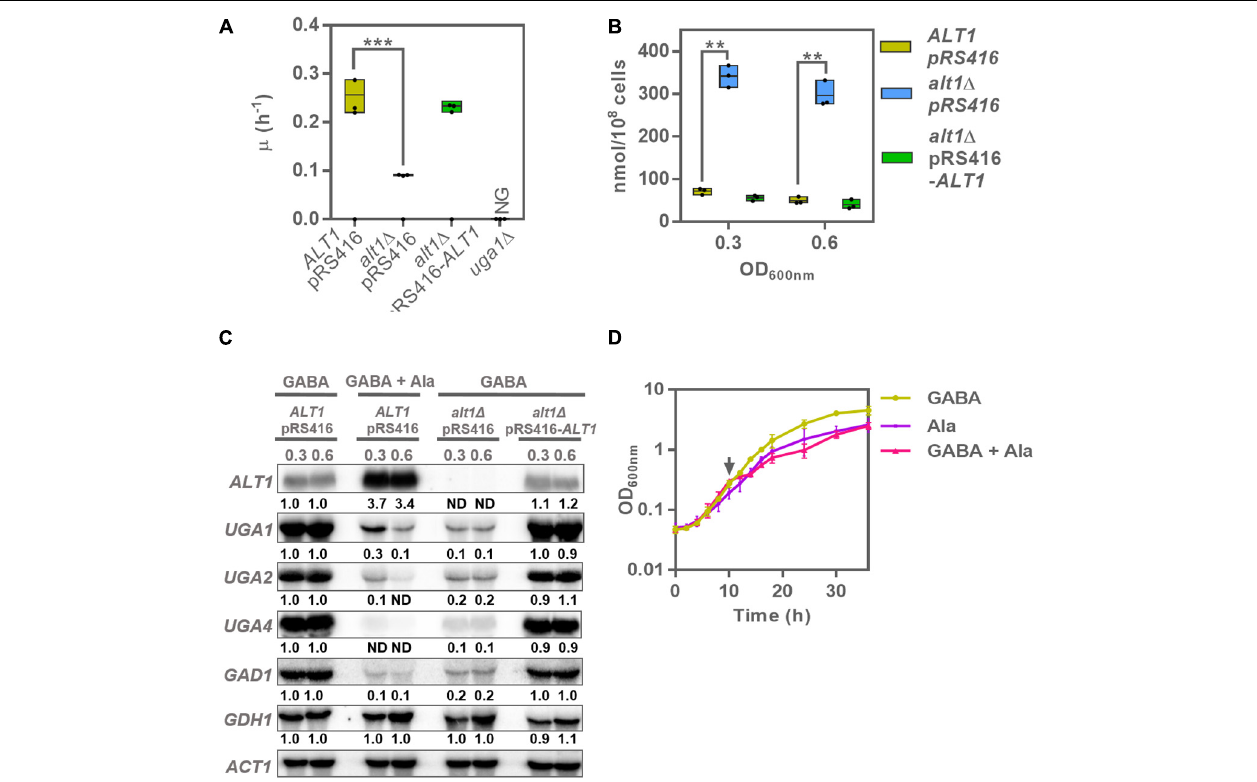
FIGURE 3 | An alt1 (cid:49) mutant in GABA shows repressed expression of the GABA shunt genes. (A) Specific growth rate in glucose GABA of wild-type strain ( ALT1 pRS416), alt1 (cid:49) mutant strain ( alt1 (cid:49) pRS416), complemented strain ( alt1 (cid:49) pRS416- ALT1 ), and uga1 (cid:49) strain. (B) Intracellular alanine concentration obtained in extracts of cultures grown on glucose + GABA at OD 600 nm = 0.3 and 0.6. Boxes show individual values (points) and the average (middle line) ± SE of three independent experiments. Asterisks indicate significant differences [ ***P < 0.001 and **P < 0.01, t -test (Student)]. (C) Northern blot assay prepared from total RNA prepared from glucose GABA grown cells at OD 600 nm = 0.3 and 0.6. Numbers below the blots represent the fold change with respect to the ALT1 pRS416 strain grown in GABA (rows 1 and 2) after quantification and normalization relative to ACT1 . (D) Growth of the wild-type strain ( ALT1 pRS416) in GABA, alanine, and GABA + alanine. Alanine was added at OD 600 nm = 0.3 (arrow) only for the sample grown in GABA + alanine. Each curve represents the average ± SE of three independent experiments. Abbreviations: NG, no growth; ND, not